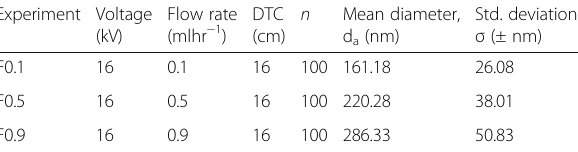
Table 1 The diameter size distribution of nanofiber for all the sample with different flow rate Experiment Voltage (kV)